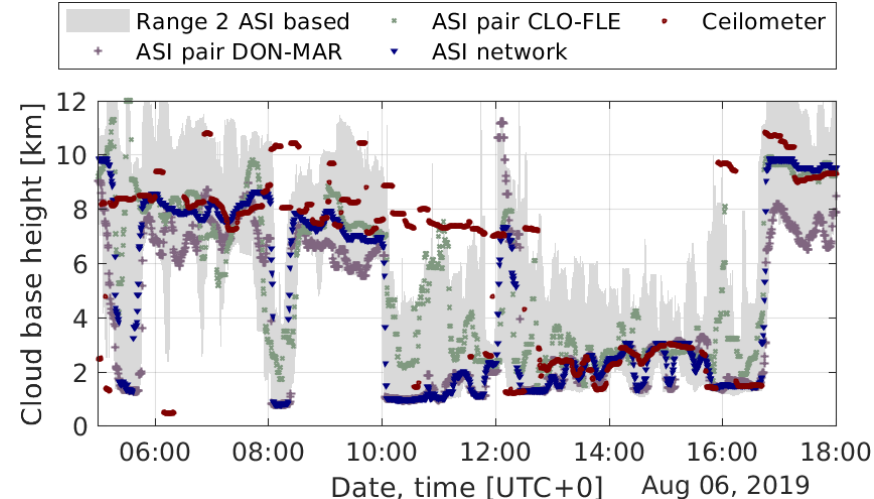
Figure B2. Time series of cloud base height for an exemplary day (6 August 2019) measured by 42 ASI pairs (gray filled), by two exemplary ASI pairs, DON-MAR and CLO-FLE with respective camera distances 0 . 8 and 4 . 2km, by the ASI network with refinements and by a ceilometer in the urban area of Oldenburg.